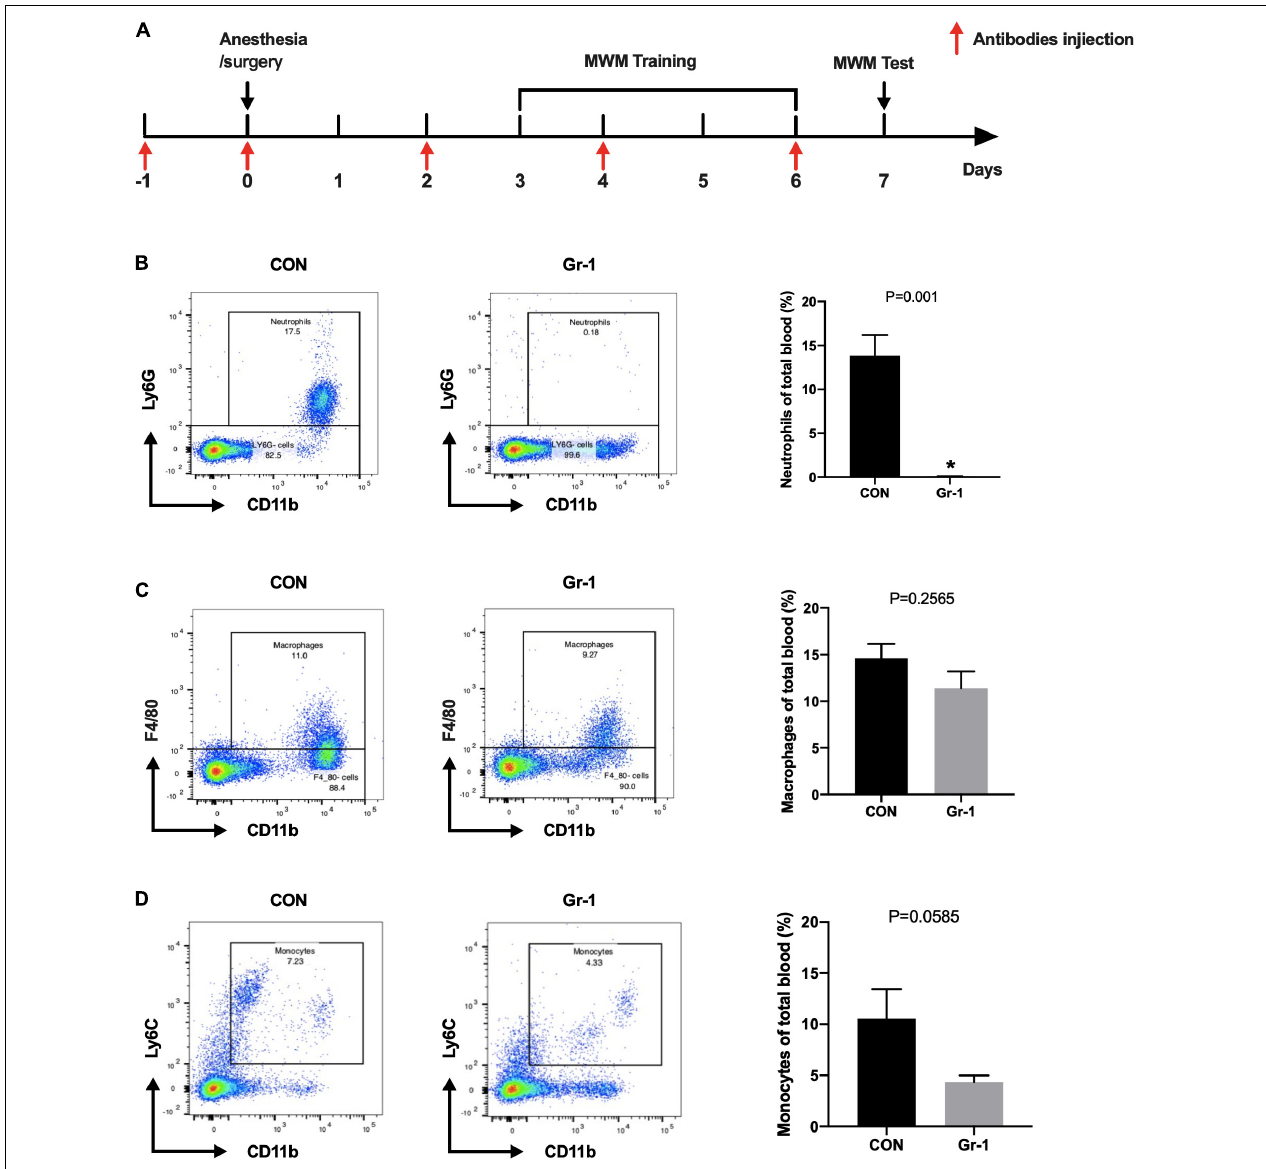
FIGURE 4 | Efficiency of neutrophils depletion with anti-Gr-1 antibody. (A) Schematic timeline of the MWM experimental paradigm with neutrophils depletion treatment. (B) After anti-Gr-1 treatment, circulating neutrophils were effectively depleted. The percentage of neutrophils in whole blood was calculated, and the efficiency of the depletion is shown ( n = 3–4 per group, P = 0.001). Proportions of macrophages ( C , P = 0.2565) and monocytes ( D , P = 0.0585) were not decreased significantly after anti-Gr-1 administration. Data are expressed as mean ± SE ( n = 3–4 per group). * P < 0.05 compared with that of the control